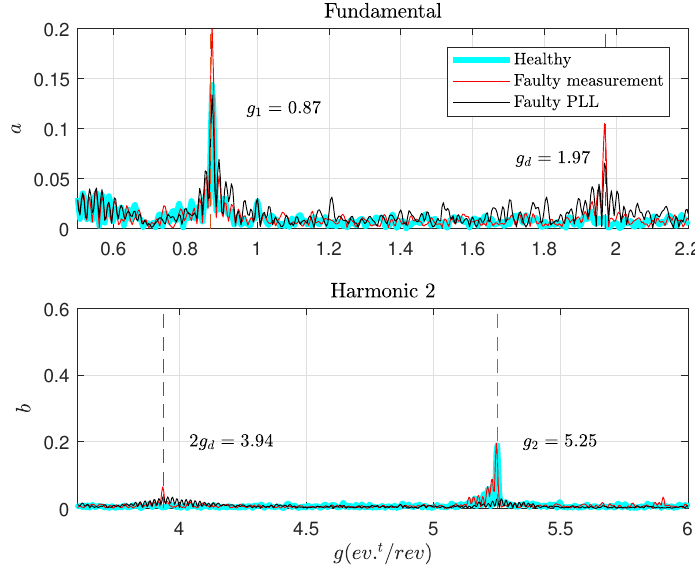
Figure 11. Angular spectrum of mechanical